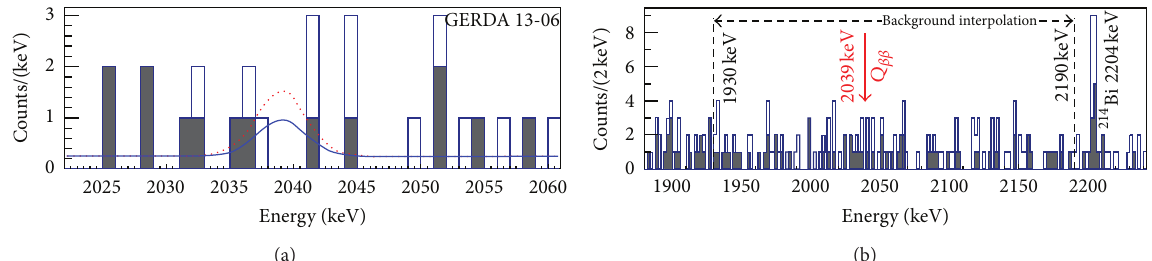
Figure 14: (a): Energy spectrum for the sum of all enr Ge detectors in the range 2020–2060 keV, without PSD (empty histogram) and with PSD (black histogram). The red dashed curve is the expectation based on the central value of [19]; the blue curve is instead based on the 90% upper limit derived by Gerda, 𝑇 0 ] 1/2 = 2.1 ×10 25 yr. (b): Energy spectrum in the range 1880–2240 keV; the vertical dashed lines indicate the interval 1930–2190 keV used for the background estimation. From [33].